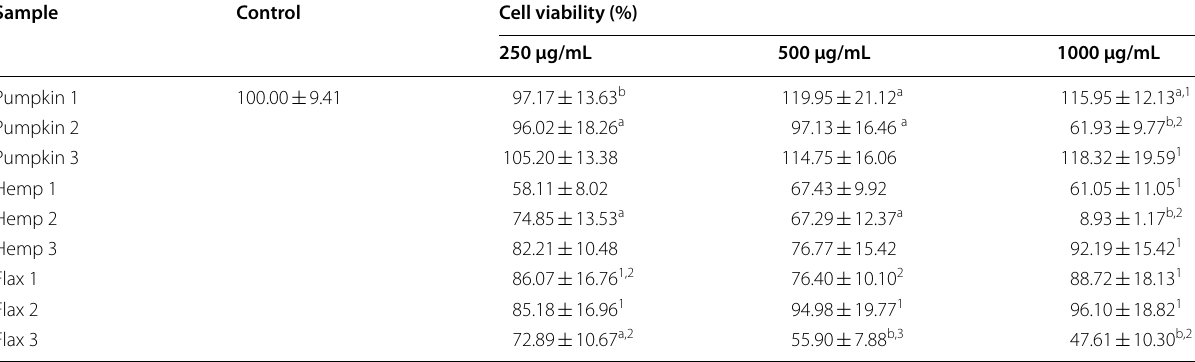
Values are expressed as mean standard deviation ( n 6) ± = Different letters (a, b, c) in the same row indicate significant differences between concentrations of the same sample extracted by different methodologies ( p < 0.05), according to Tukey’s HSD test Different superscript numbers (1,2,3) in the same species at the same concentration represent significant differences ( p < 0.05) between the extraction technique employed ( p < 0.05), according to Tukey’s HSD test Subcritical water extraction carried out with a solid to solvent ratio of 1:30 (w/v), 1 h at 160 °C with (1) 20 bar N 2 , (2) 20 bar N 2 with 0.05 M HCl, (3) 20 bar CO 2